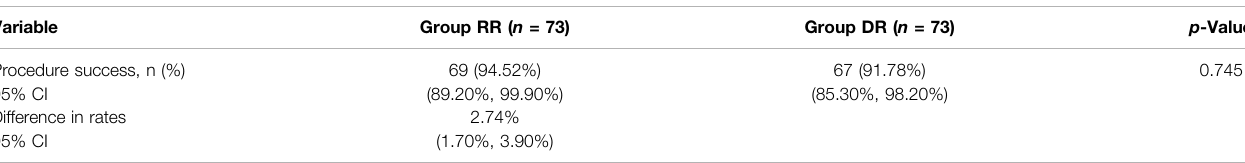
TABLE 2 | Difference of the successful completion rate of procedure between two groups.